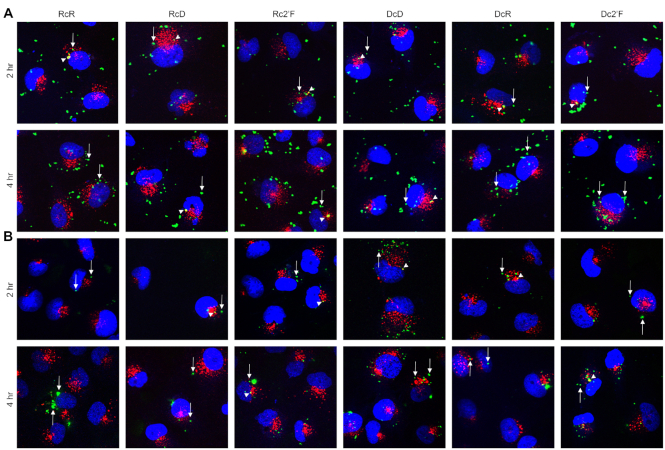
NANPs are internalized through endocytic pathway and traffic to the cytosol. Microglia were transfected with 5 nM Cy3-labeled NANPs using L2K (A) or DOTAP (B) for 2 or 4 h. Localization of NANPs (green) within cells was determined by immunofluorescence microscopy for the early endosomal marker, EEA1 (red), and nuclear stain DAPI (blue). Arrow heads indicate NANPs colocalized with EEA1, and arrows indicate NANPs that do not colocalize with EEA1.